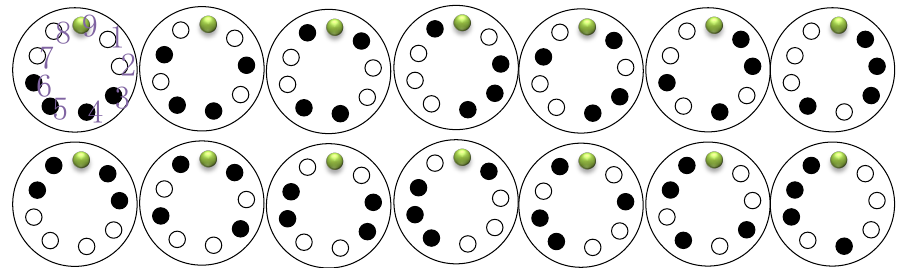
Figure 1. A Latin matching of order 5 defined according to